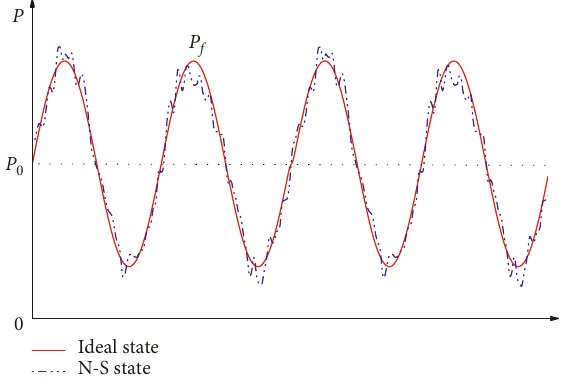
Figure 5: Internal pressure values imposed by the